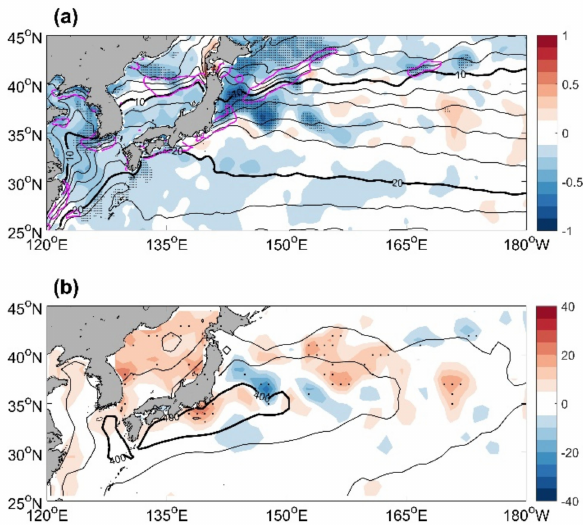
Figure 2. ( a ) The estimated SST response (shading, unit: ◦ C) in DJF onto the KEI 2 months earlier and the climatological SST (contours at 2 ◦ C intervals) in DJF. The SSTs at 10 ◦ and 20 ◦ C are marked by the thick black contours. The magenta contours represent the climatological SST meridional gradient of − 2.5 × 10 − 6 K m − 1 . ( b ) The estimated THF response (shading, unit: Wm − 2 ) in DJF onto the KEI 2 months earlier and the climatological THF (contours at 100-Wm − 2 intervals) in DJF. The THF at 400 Wm − 2 is denoted by the thick black contours. A positive value of THF illustrates the upward transportation of THF from the ocean into the atmosphere. Stippling indicates the 90% confidence